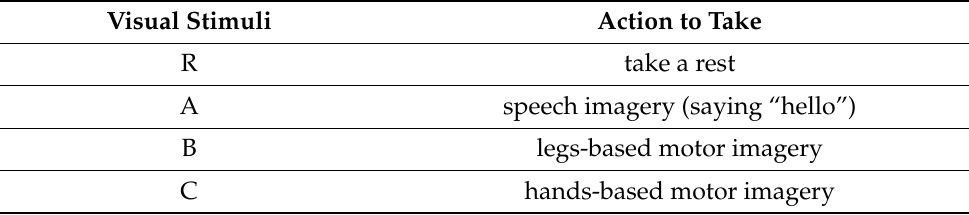
Table 1. Types of visual stimuli used in